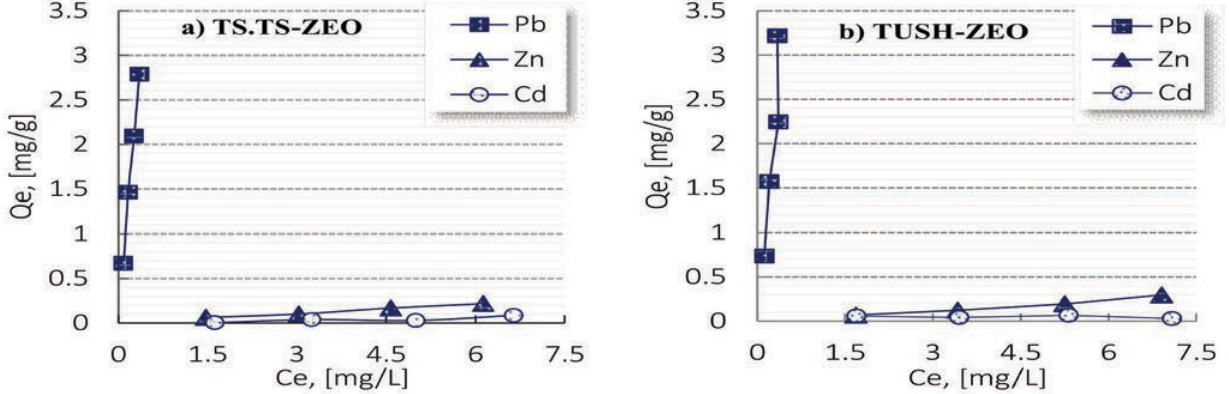
Fig. 6. Adsorption isotherms of heavy metals with a) TS.TS-ZEO and b)